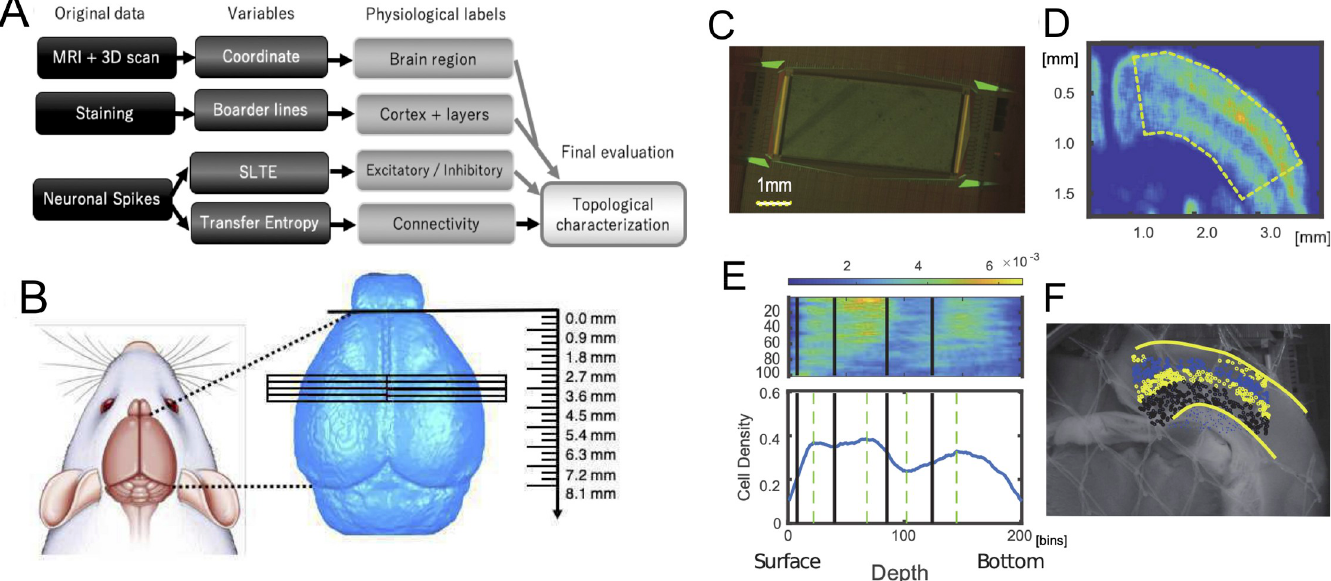
Fig 1. Data process pipeline, brain regions, slices, staining and layer detections: A Data process pipeline of the entire data process flow by four sets of data; MRI, 3D scan, Staining and Neuronal spikes. First, MRIs and 3D scans were prepared and analysed to obtain coordinates of brain slices. Second, physiological information, such as boundaries of the cortical areas within the slices, the cortical layers were defined by staining data, and excitatory and/or inhibitory cells. Third, the connectivity architectures were provided by indices of Transfer Entropy (TE). Finally, topological characteristics were calculated from the connectivity architectures while comparing them with other physiological labels and analyzed. B Brain regions’ boundaries are estimated through anatomical coordinates used to prepare slices from left or right cortical hemispheres. The three dimensional view of recorded brain regions is shown in S1 Fig. C Multi-electrode array photograph used in this study. D Smoothed NeuN staining image shows Non-uniformity of density of neurons. The curved regions show as dotted lines in the panel. E Density expressed at the panel D was re- shaped into a straight box as shown in the top panel at E , and the sum along the y-axis orthogonal to the cortical surface was expressed at the lower panel of E . Four layer boundaries were then determined and shown as thick lines in the lower panels being mapped onto the non-stained photographic image. F All neurons identified from the spike sorting process were categorized into individual layers.